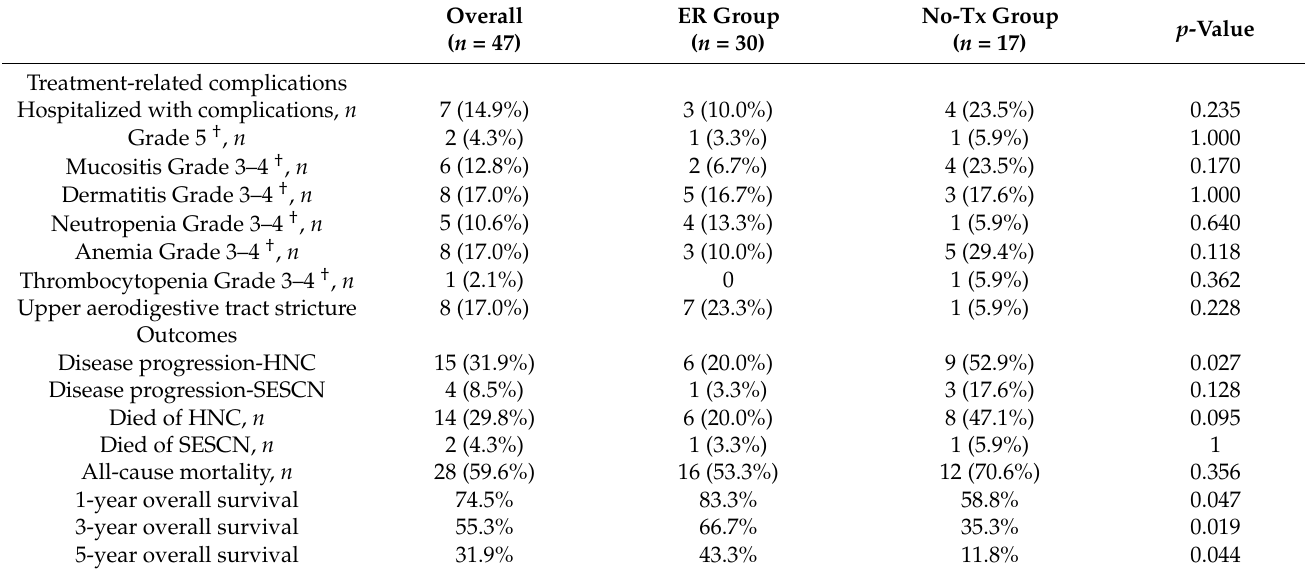
Table 2. Treatment-related complications and outcomes.